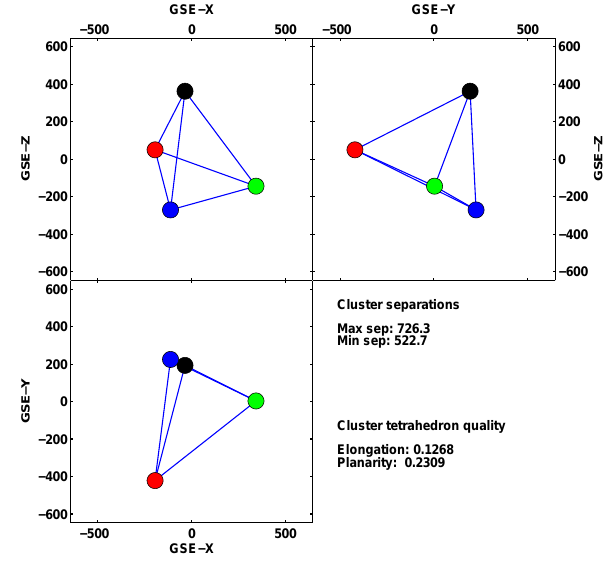
Fig. 2. The configuration of the Cluster tetrahedron as they en- countered the shock on 31 March 2001 at 17:18 UT. The different satellites are shown using the colour scheme black, red, green, and blue for satellites 1, 2, 3, and 4, respectively. This colour scheme is used throughout this paper when multi-satellite data are